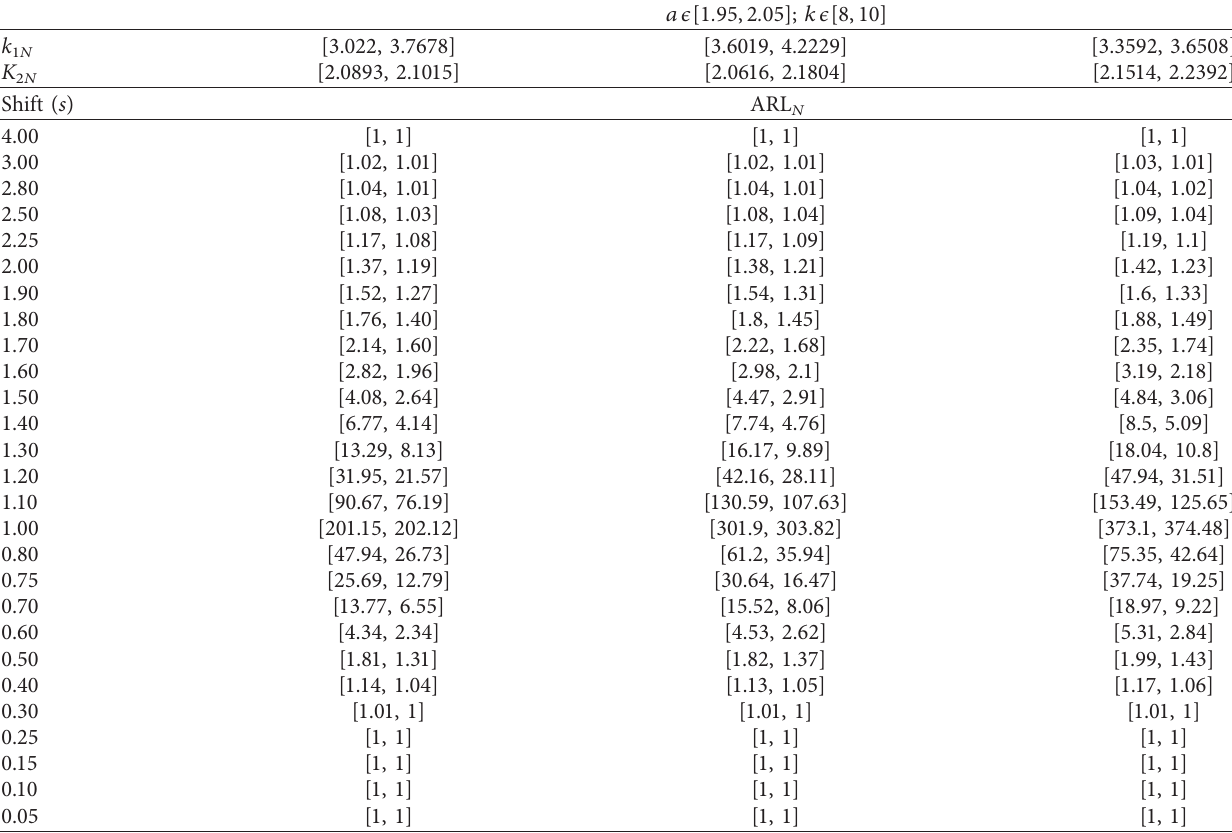
Table 2: The values of NARL when a � 1 . 95 and 2 . 05 and k � 8 and 10.